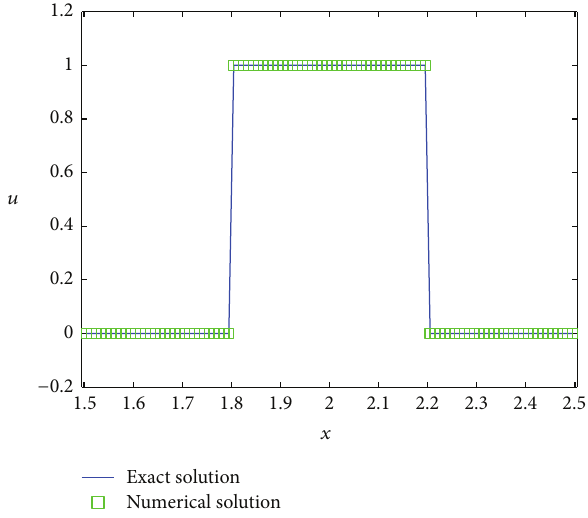
Figure 6: SHA method with TVD (27b) applied to linear advection equation for a square wave; numerical (symbols) and exact (line) solutions are compared at 𝑡 = 2